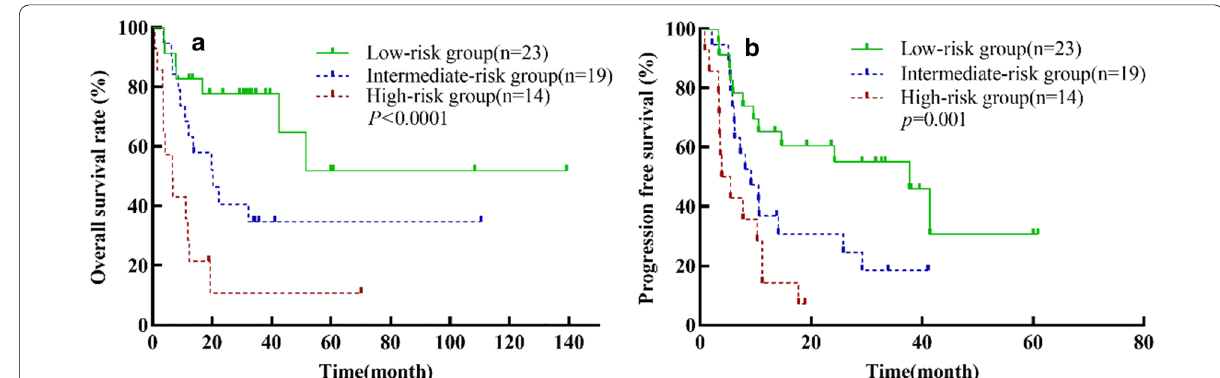
Fig. 2 The Kaplan–Meier survival analyses and curves of OS ( a ) and PFS ( b ) according to the combination of TMTV > 514.6 cm 3 and PIT > 1. p